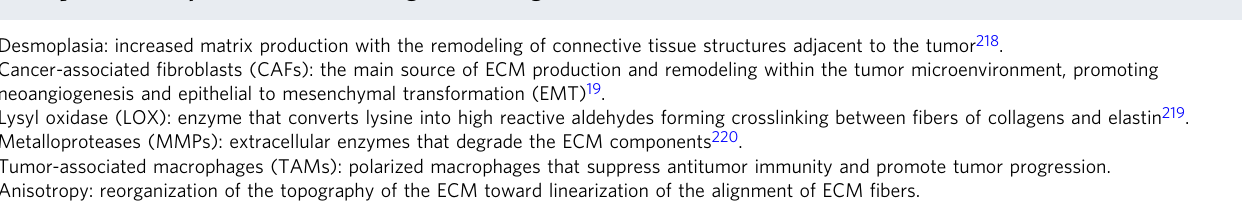
Desmoplasia: increased matrix production with the remodeling of connective tissue structures adjacent to the tumor 218 . Cancer-associated fi broblasts (CAFs): the main source of ECM production and remodeling within the tumor microenvironment, promoting neoangiogenesis and epithelial to mesenchymal transformation (EMT) 19 . Lysyl oxidase (LOX): enzyme that converts lysine into high reactive aldehydes forming crosslinking between fi bers of collagens and elastin 219 . Metalloproteases (MMPs): extracellular enzymes that degrade the ECM components 220 . Tumor-associated macrophages (TAMs): polarized macrophages that suppress antitumor immunity and promote tumor